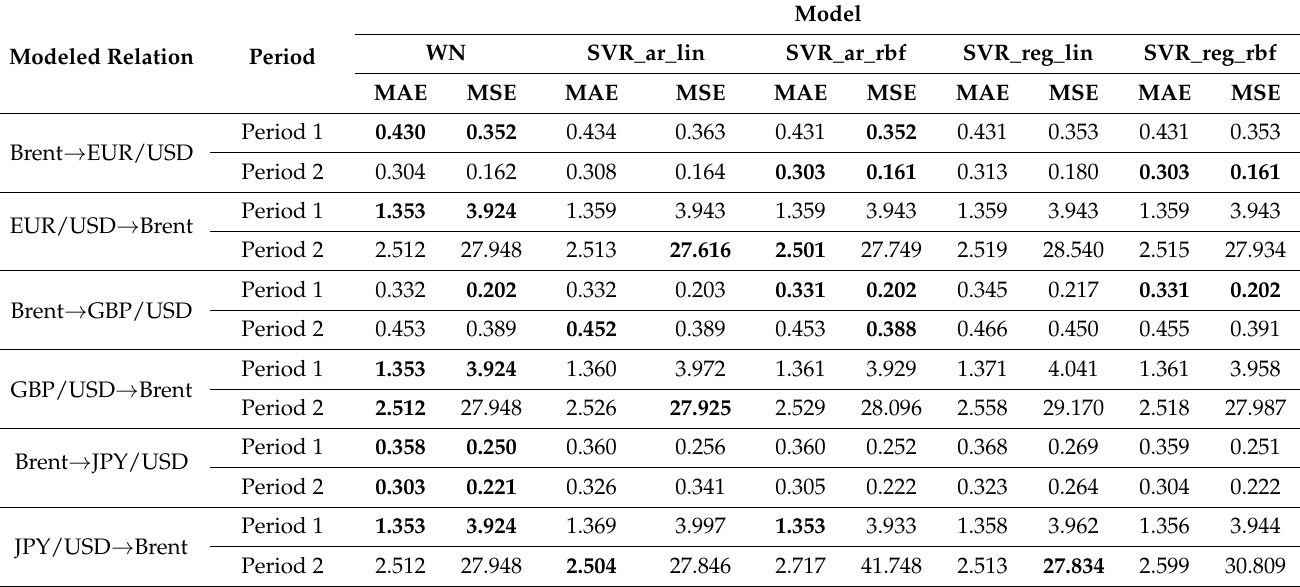
Table 6. Accuracy measures of the forecasts from the constructed SVR